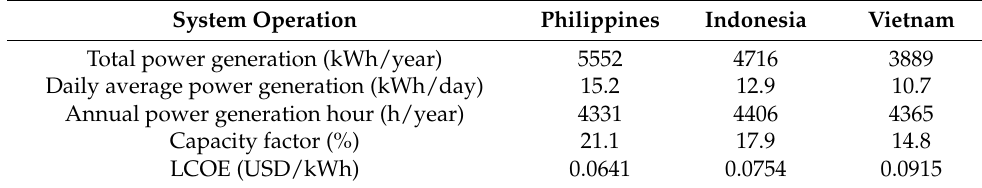
Table 11. Comparison of solar PV performance in the three